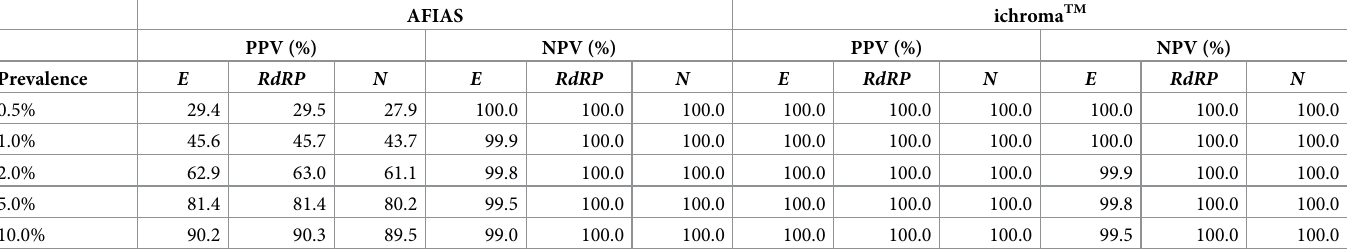
Table 2. Simulated negative and positive predictive values of the AFIAS COVID-19 Ag and the ichroma TM COVID-19 Ag assays according to the disease prevalence for the SARS-CoV-2 positive nasopharyngeal swab specimens with cycle threshold values less than 25. AFIAS ichroma